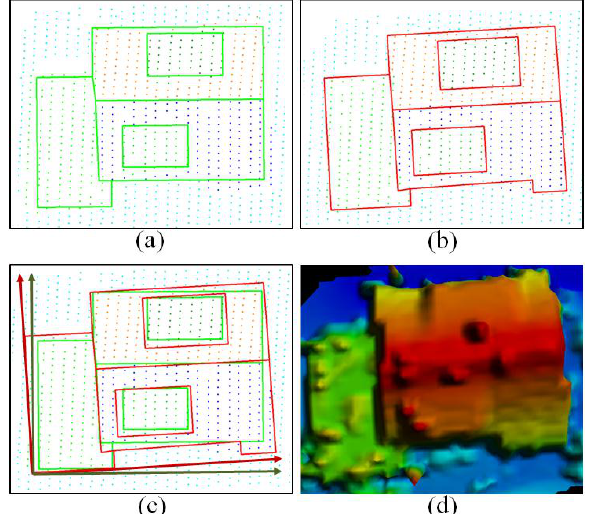
Figure 5. Comparison of rooftop modelling results in building orientation;(a) L-Model, (b) sequential modelling results, (c) overlaid rooftop models, and (d) LiDAR